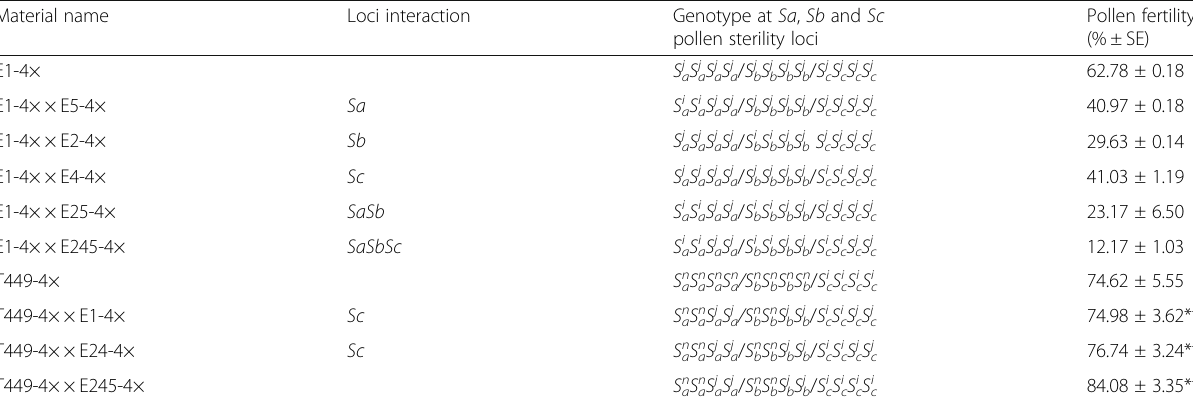
Table 1 Pollen fertility of autotetraploid hybrids with genetic interactions at Sa , Sb and Sc